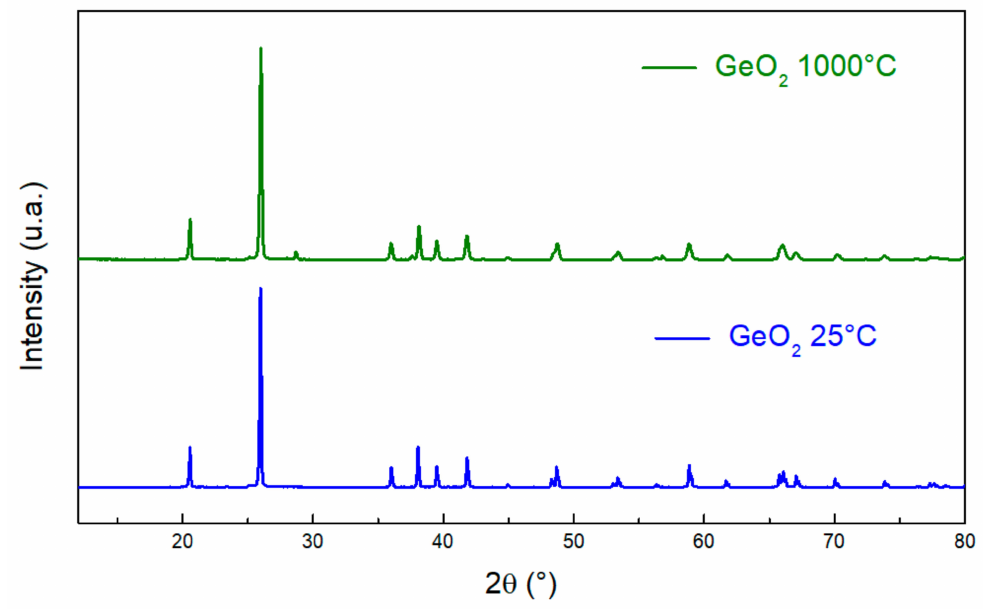
Figure 5. XRD patterns of GeO 2 before (blue) and after (green) thermal treatment at 1000 ◦